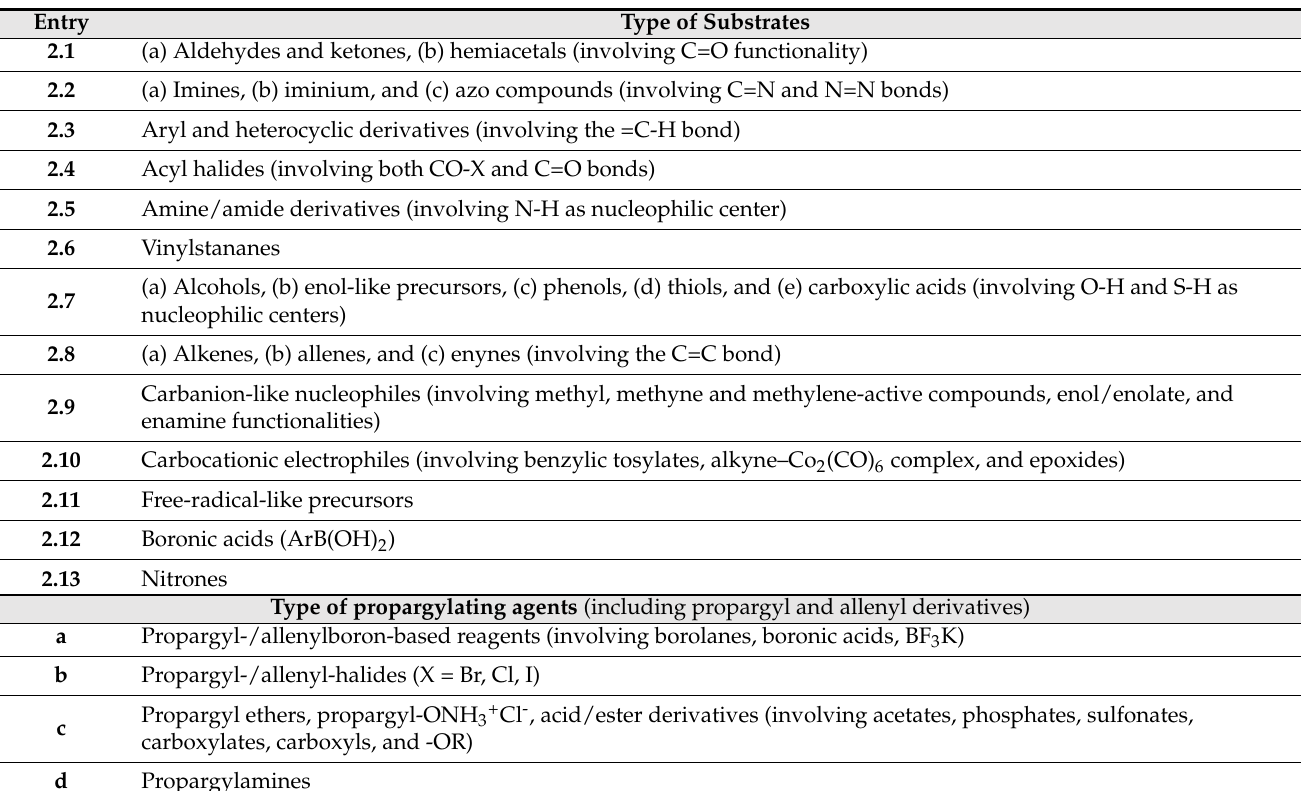
Table 1. Summary of the types of substrates, propargylating agents, and catalysts/catalytic